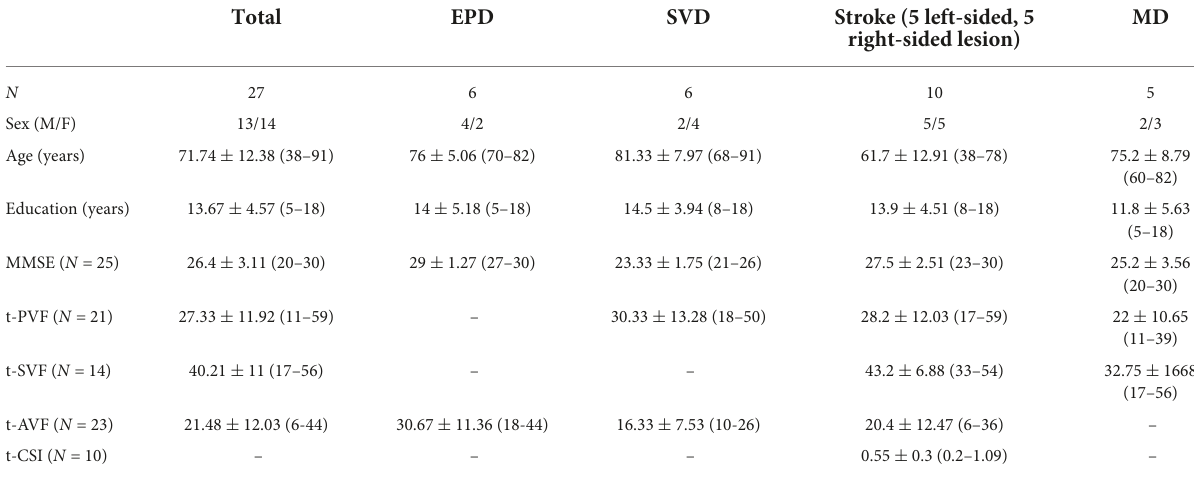
TABLE 4 Patients’ demographic, clinical, and cognitive